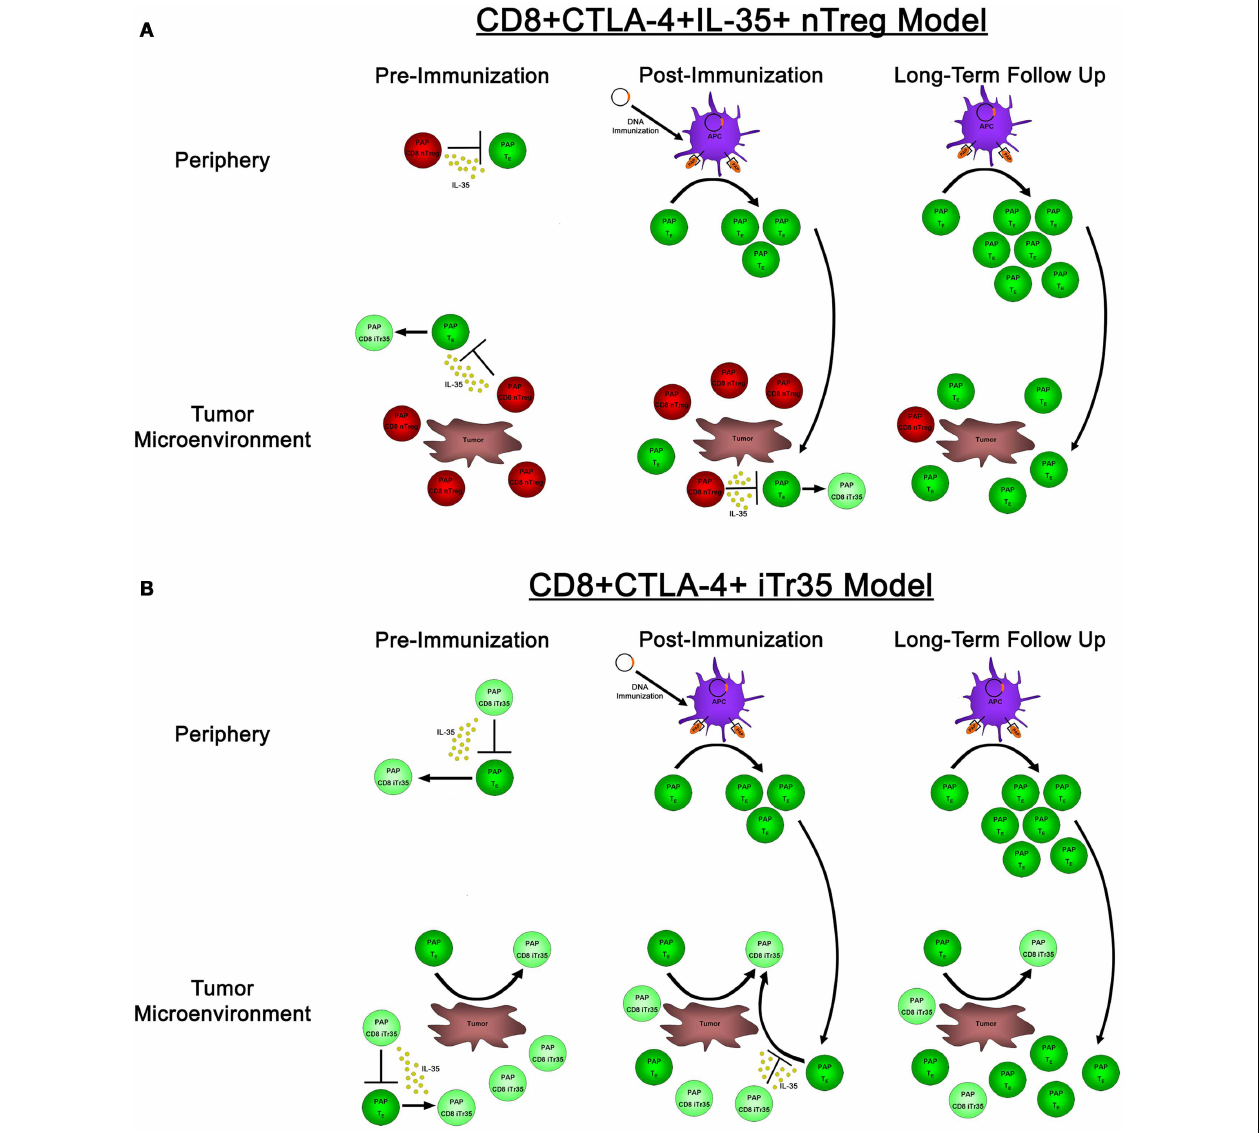
proliferation and effector functions. It is not until long-term follow up when these effector responses are able to outnumber antigen-specific nTreg, leading to the generation of productive anti-tumor immunity. (B) In a model where CD8 + CTLA-4 + T cells represent a population of novel CD8 + iTr35 cells (light green cells), these iTregs would be able to convert effector cells (dark green) into additional iTreg through their expression of IL-35, thus propagating infectious tolerance to prevent the generation of productive anti-tumor immunity both pre-immunization as well as immediately post-immunization. This process would be predicted to continue until long-term follow up, when antigen-specific effectors could expand to a sufficient level to outnumber these iTreg responses, and potentially prevent the generation of induced antigen-specificTreg by promoting tumor destruction and a non-suppressive tumor